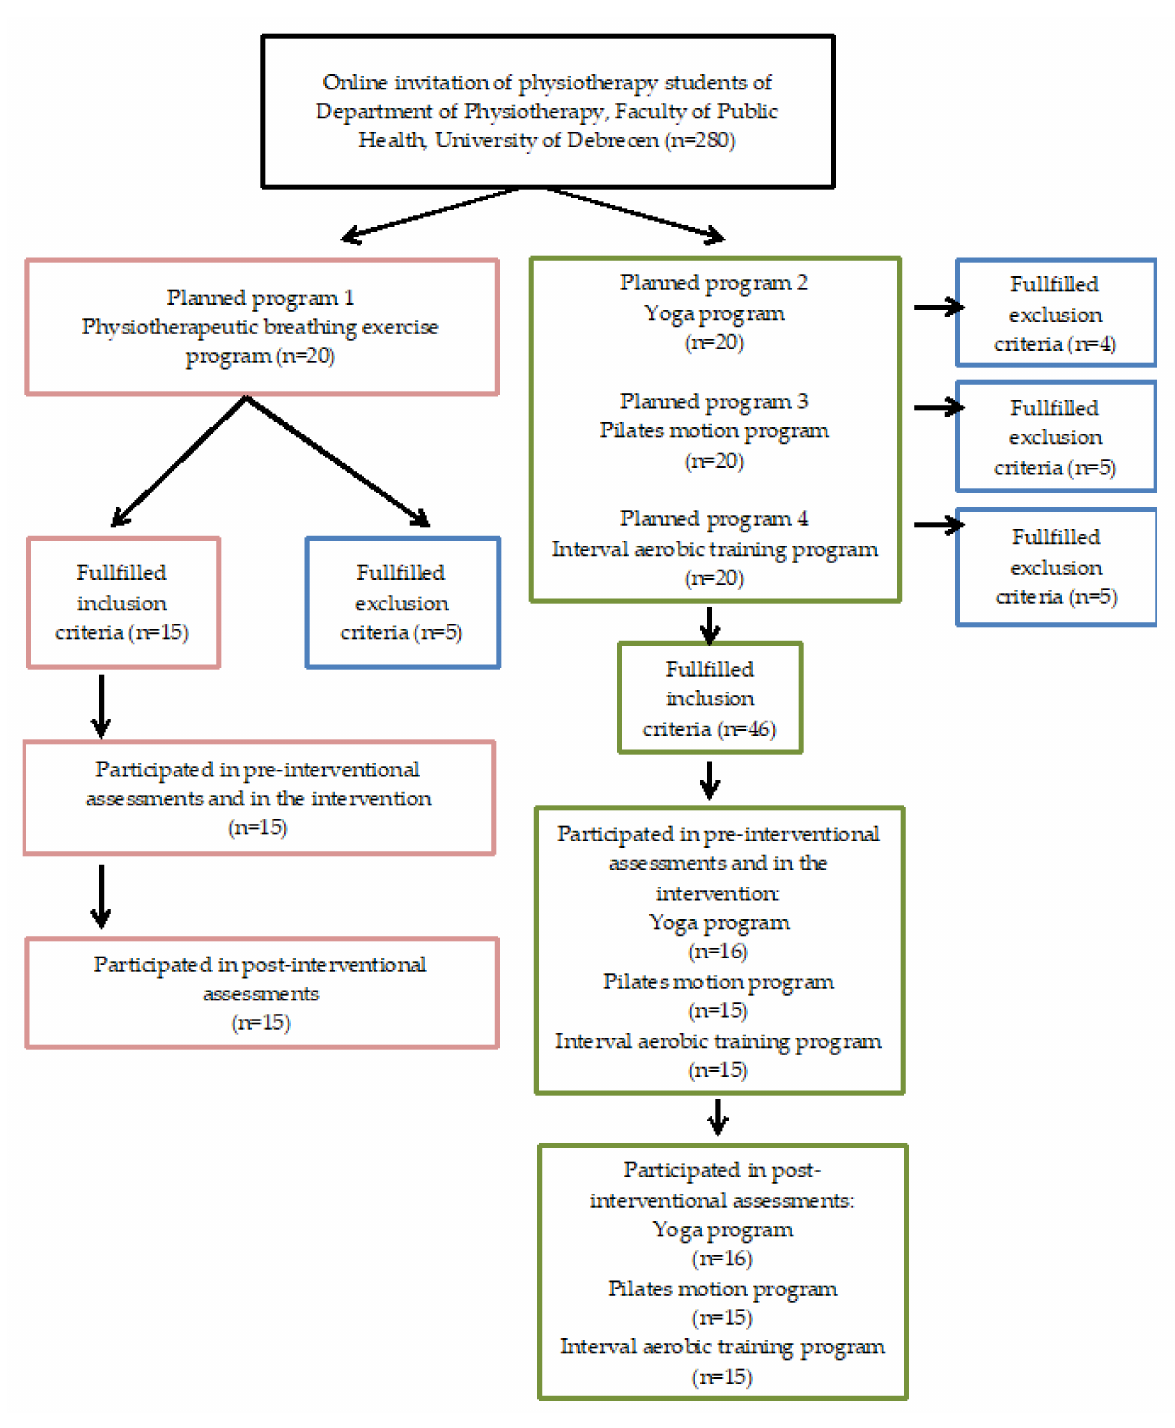
Figure 1. Flow diagram of subject selection process of the